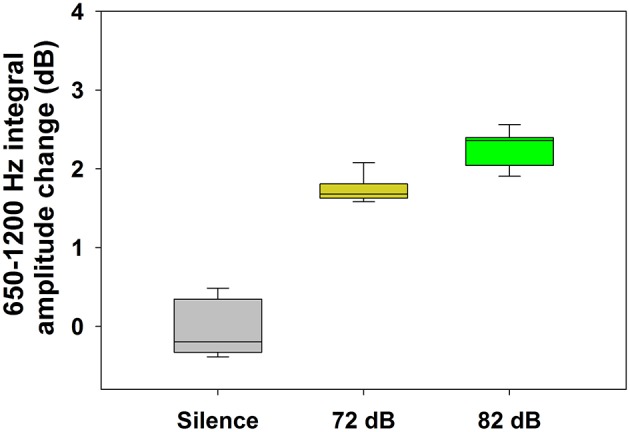
Increase of the TEN 1,000 Hz peak amplitude during auditory stimulation with broad-band noise in the majority of the subjects (n = 9). This graph shows the effect (in dB) of broad-band noise stimulation on the nine subjects with an increase in the amplitude of the TEN 1,000 Hz peak (measured as the integral value between 650 and 1,200 Hz) [One way ANOVA, F(2) = 241.420, p < 0.001; Tukey post-hoc, p < 0.05 in the three pairwise comparisons]. In addition to the amplitude increase of the TEN 1,000 Hz peak observed in these nine subjects, in two cases we found an amplitude decrease with broad-band noise stimulation.